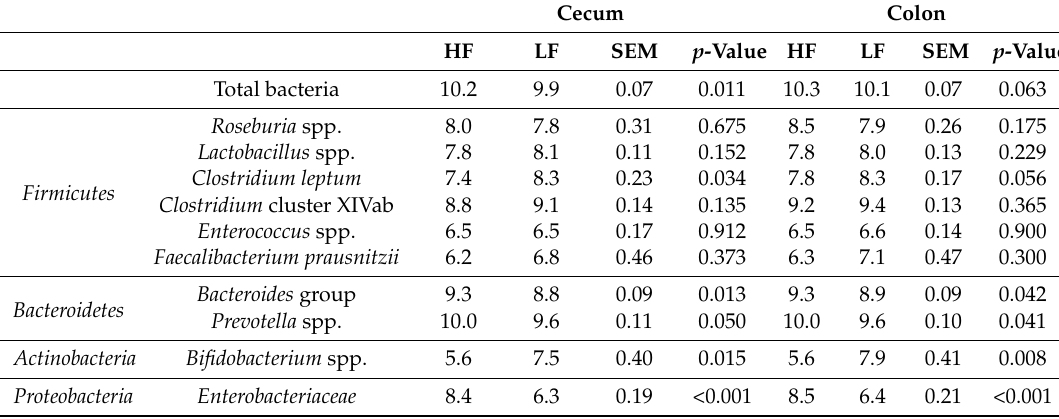
Table 4. Effect of diet on bacterial numbers in cecal and colonic digesta of pigs (log 10 16S ribosomal RNA gene copies/g fresh